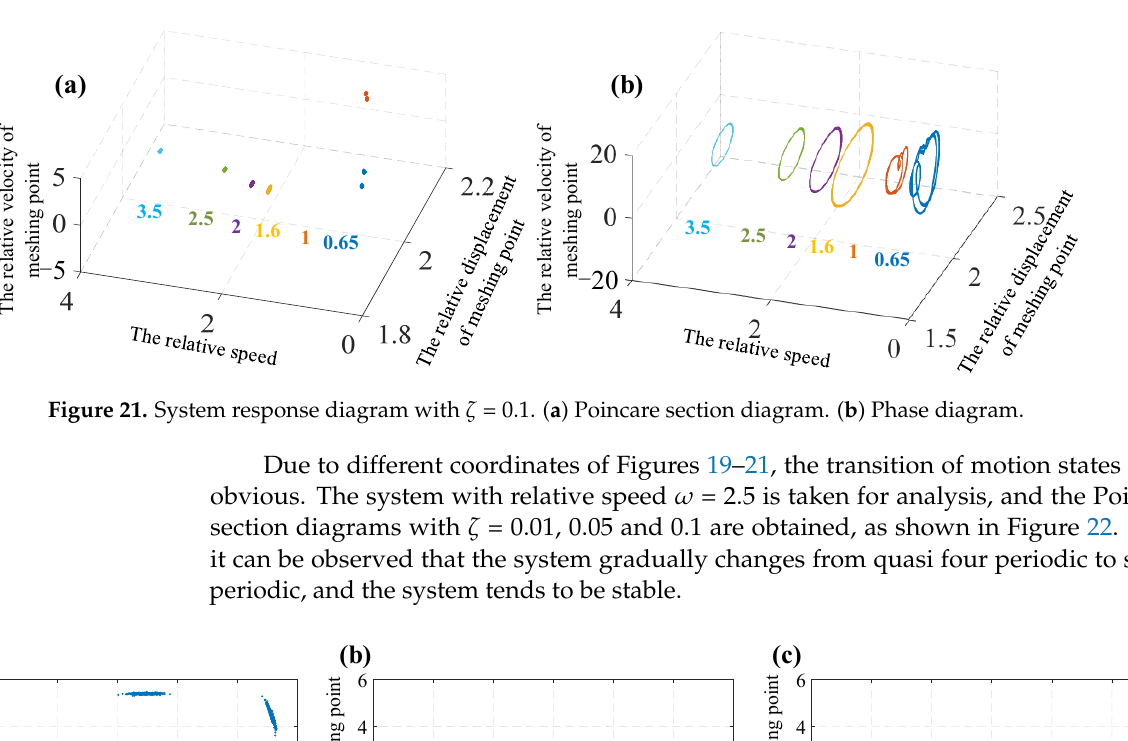
(1) With the increase of the fractal dimension D , the uncertainty and the amplitude of backlash decrease. Then, the meshing force is reduced, and the wear is small when the gear runs for the same time. The influence on the dynamic wear model is reduced, and the stability of the system considering dynamic wear is enhanced. Therefore, the stable backlash can slow down the tooth surface wear. (2) The friction coefficient and rotational speed of the tooth surface have an important influence on the temperature of the tooth surface. With the increase of the friction coeffi- cient, the flash temperature and root mean square value of displacement increase, and the system tends to be unstable. (3) With the increase of the damping ratio, the system changes from unstable quasi- periodic and chaotic motion to stable periodic motion. The increase of damping acceler- ates the energy loss of the system, makes the system tend to be stable, and has the effect of reducing wear. Author Contributions: J.X.: Conceptualization, Methodology, Software, Writing—original draft, In- vestigation. X.L.: Writing—review and editing, Supervision, Formal analysis. R.C.: Software, Vali- dation, Visualization, Data curation. L.W.: Software, Validation, Visualization. Z.Y.: Software, Vali- dation. H.Y.: Software, Validation. All authors have read and agreed to the published version of the manuscript. Funding: The project is supported by the Fundamental Research Funds for the Central Universities (N2103025), the National Key Research and Development Program of China (2020YFB2007802), and the National Natural Science Foundation of China (Grant No. 51875092). Institutional Review Board Statement: Not applicable. Informed Consent Statement: Not applicable. Data Availability Statement: Some data, models, or code generated or used during the study are available from the corresponding author by request. Conflicts of Interest: The authors declare no conflict of interest. References 1.